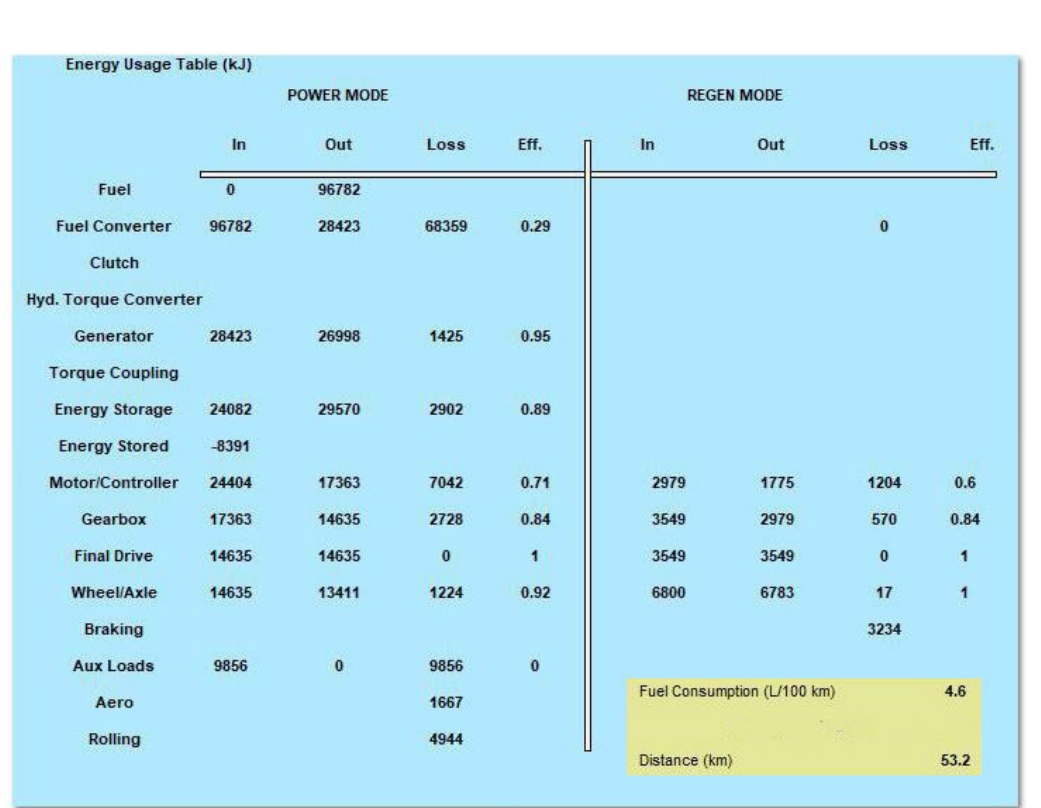
Figure 7. Energy profile and fuel consumption for the urban cycle.